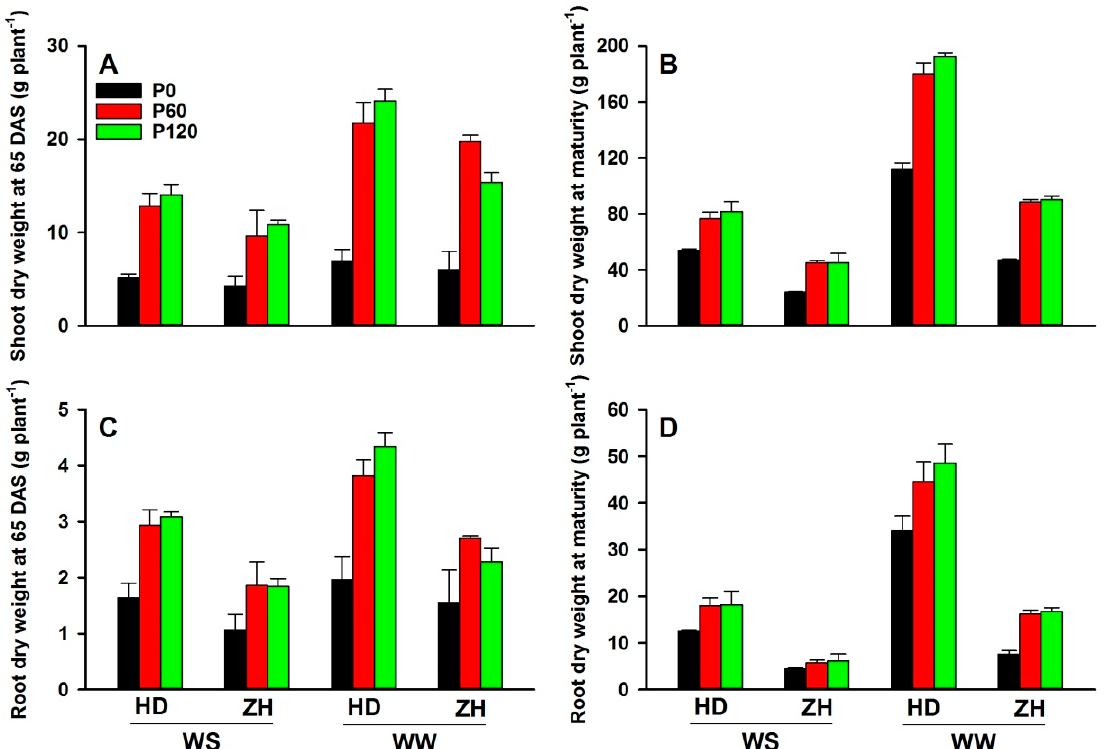
Figure 4. Shoot and root dry matter accumulated at ( A , C ) 65 days after sowing (DAS) and at ( B , D ) maturity of soybean genotypes Huangsedadou (HD) and Zhonghuang 30 (ZH) with three levels of applied P (0 (P0), 60 (P60) and 120 (P120) mg P kg –1 dry soil) and two water treatments (well-watered (WW) and cyclic water stress (WS)). Values are means + one standard error of the mean ( n = 3).